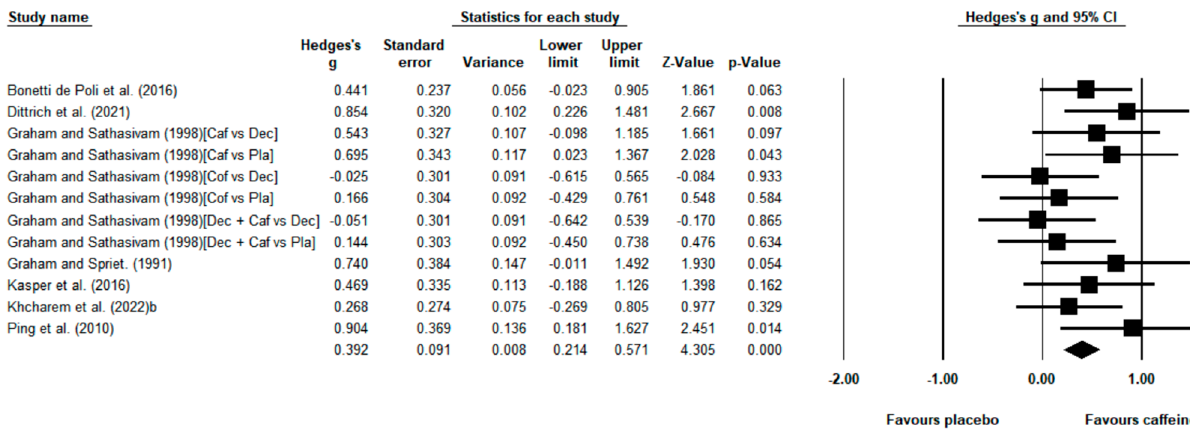
Figure 3. Effect of caffeine ingestion as compared to placebo on time to exhaustion runs. The forest plot shows standardized mean differences with 95% confidence intervals (CI) for 12 unique placebo–caffeine comparisons in 7 studies [43–47,49,51]. The diamond at the bottom of the graph represents the pooled standardized mean difference following random effects meta-analyses. A positive value reflects an increase in the time to exhaustion with caffeine with respect to the placebo. The size of the plotted squares reflects the relative statistical weight of each study. Caf, caffeine; Dec, decaffeinated coffee; Pla, placebo.